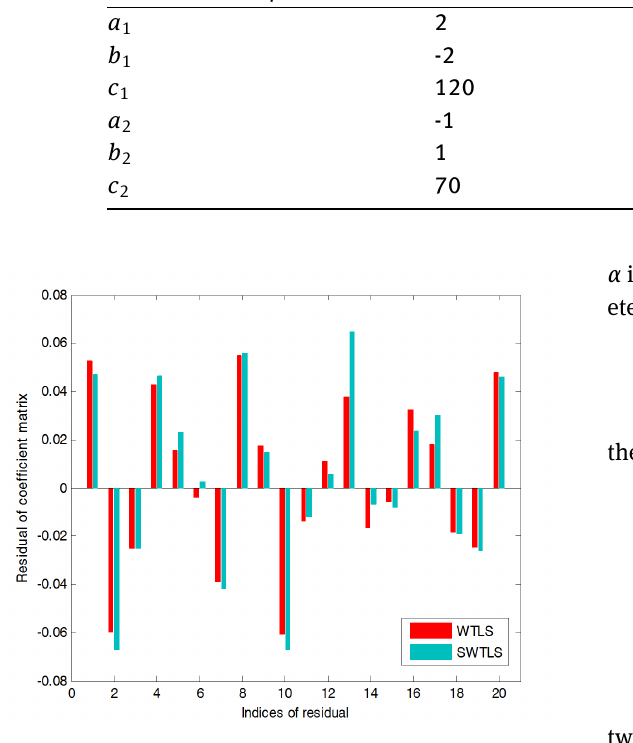
Table 2: Reference values and estimates of transformation parameters derived by WTLS and SWTLS. Transformation parameters